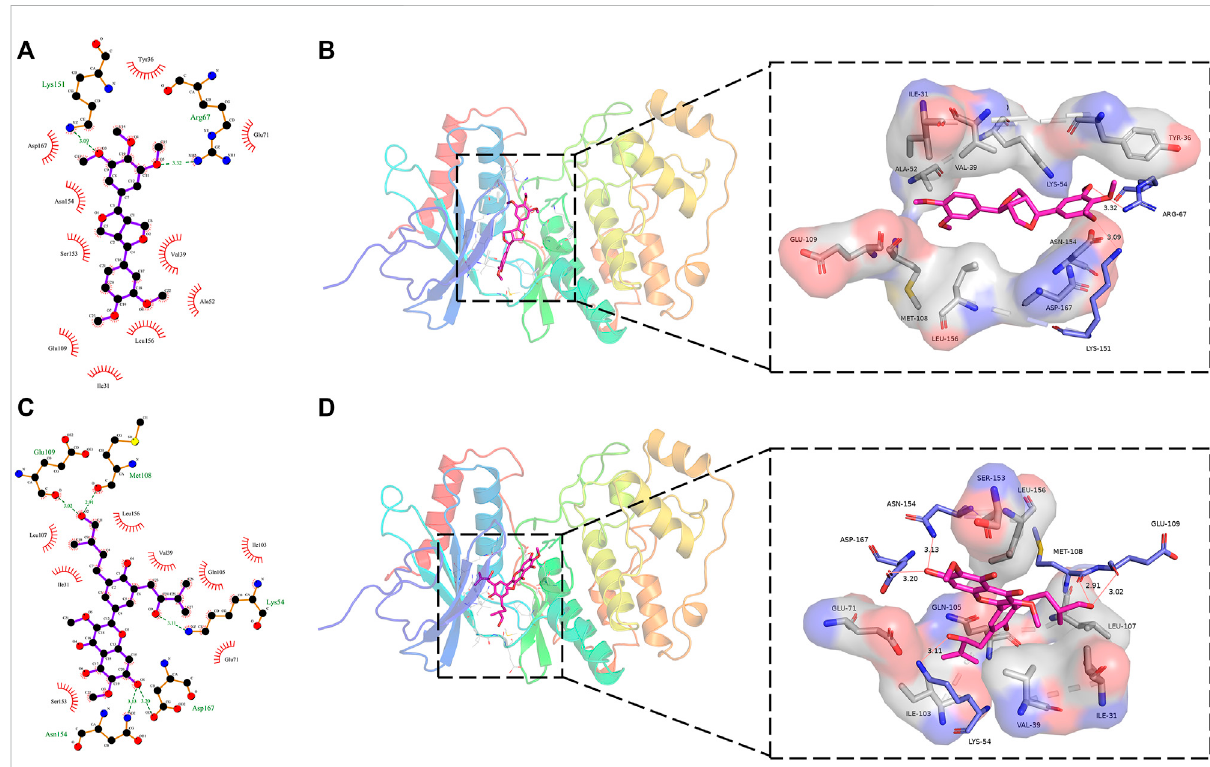
FIGURE 5 (A,B) 2D/3D binding interaction of Magnolin with ERK2 protein; (C,D) 2D/3D binding interaction of Dodoviscin A with ERK2 protein (pink structure represents small molecule ligand, blue structure represents hydrogen bond interaction residue, gray structure represents hydrophobic interaction